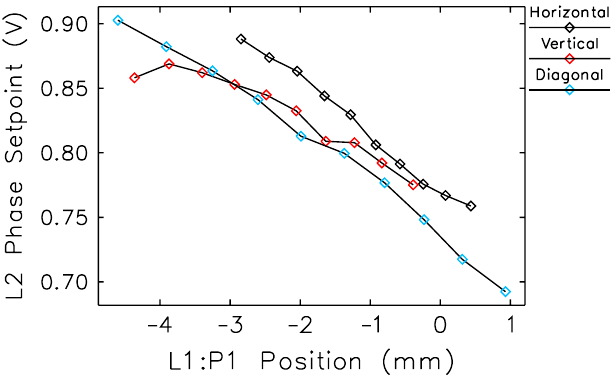
FIG. 6. (Color) Response of L2 phase detector feedback to steering at BPM L1:P1 using an upstream corrector. The results are summarized in Table I.